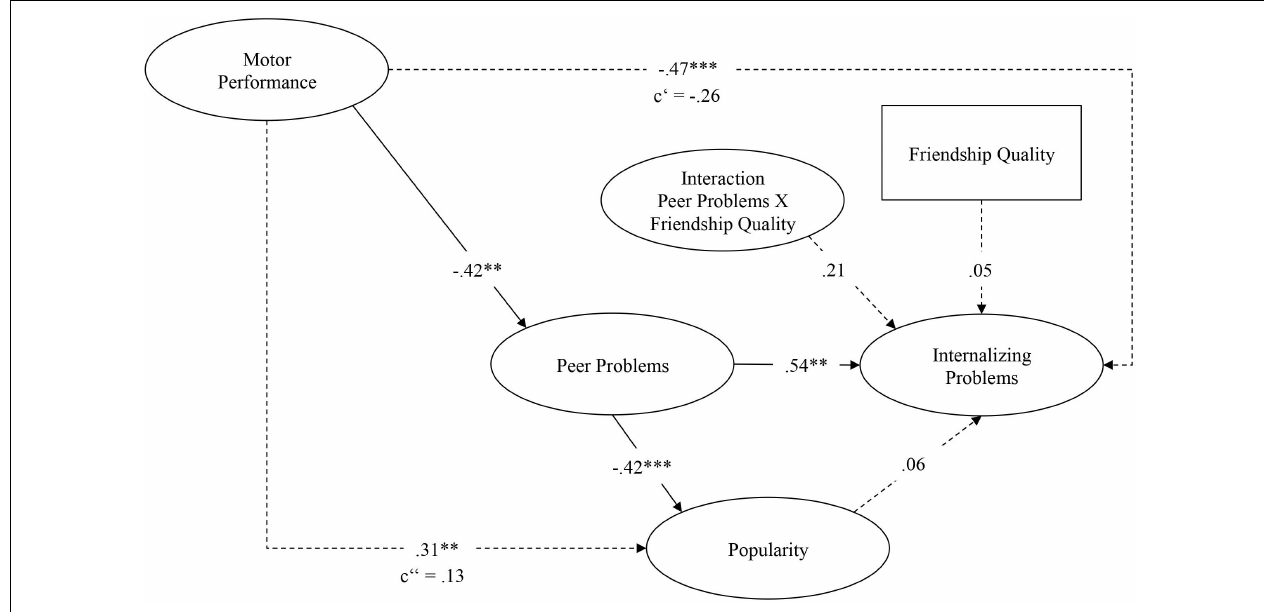
FIGURE 3 | Standardized results of the structural equation model. Model fit ( χ 2 = 160.52; df = 147; CFI = 0.97; RMSEA = 0.02; SRMR = 0.05). * p < 0.05; ** p < 0.01; *** p < 0.001.